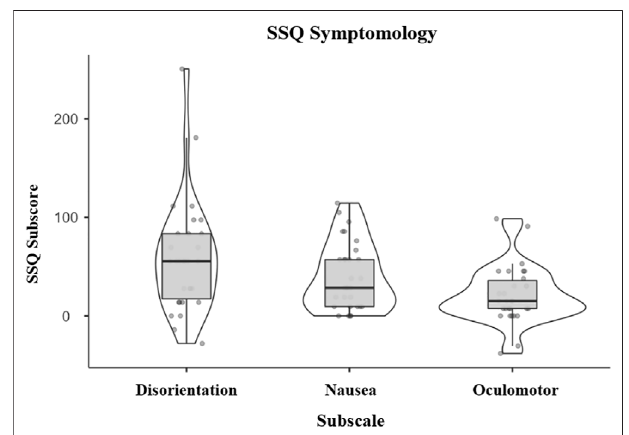
FIGURE 1 | Post-pre changes in SSQ-D (Disorientation), SSQ-N (Nausea), and SSQ-O (Oculomotor) sub-scores (for all